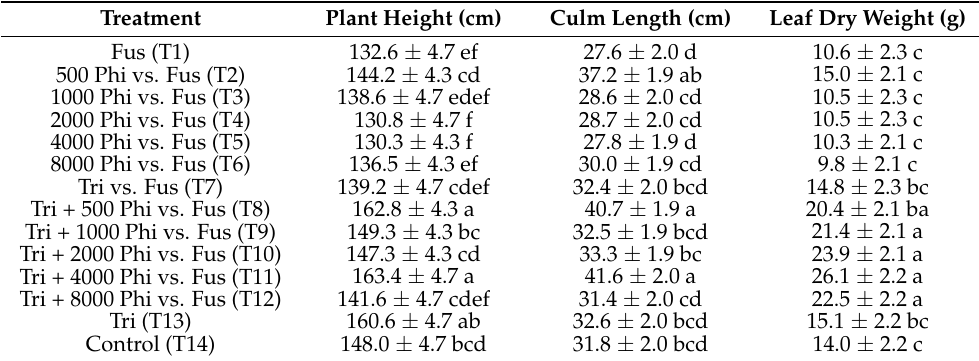
Table 3. Effect of Trichoderma sp. (Tri) and phosphite (Phi; µ g mL − 1 ) in the control of Fusarium sp. (Fus) on plant height, culm length, and leaf dry weight of sugarcane ( Saccharum spp.). Treatment Plant Height (cm) Culm Length (cm) Leaf Dry Weight